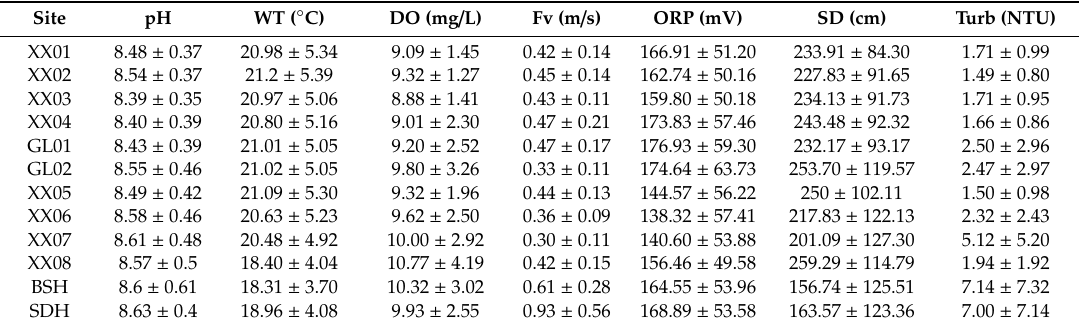
Table 1. Environmental conditions (pH, water temperature (WT), dissolved oxygen (DO), flow velocity (Fv), oxidation-reduction potential (ORP), transparency (SD), and turbidity (Turb)) at each site.